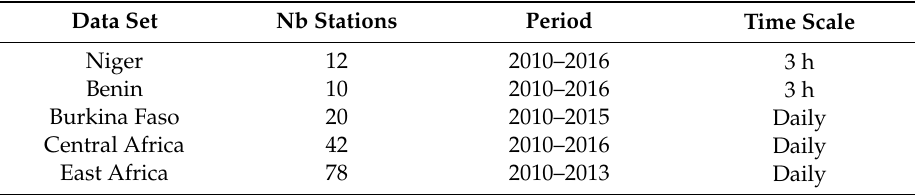
Table 1. Observed rainfall datasets used for evaluation.